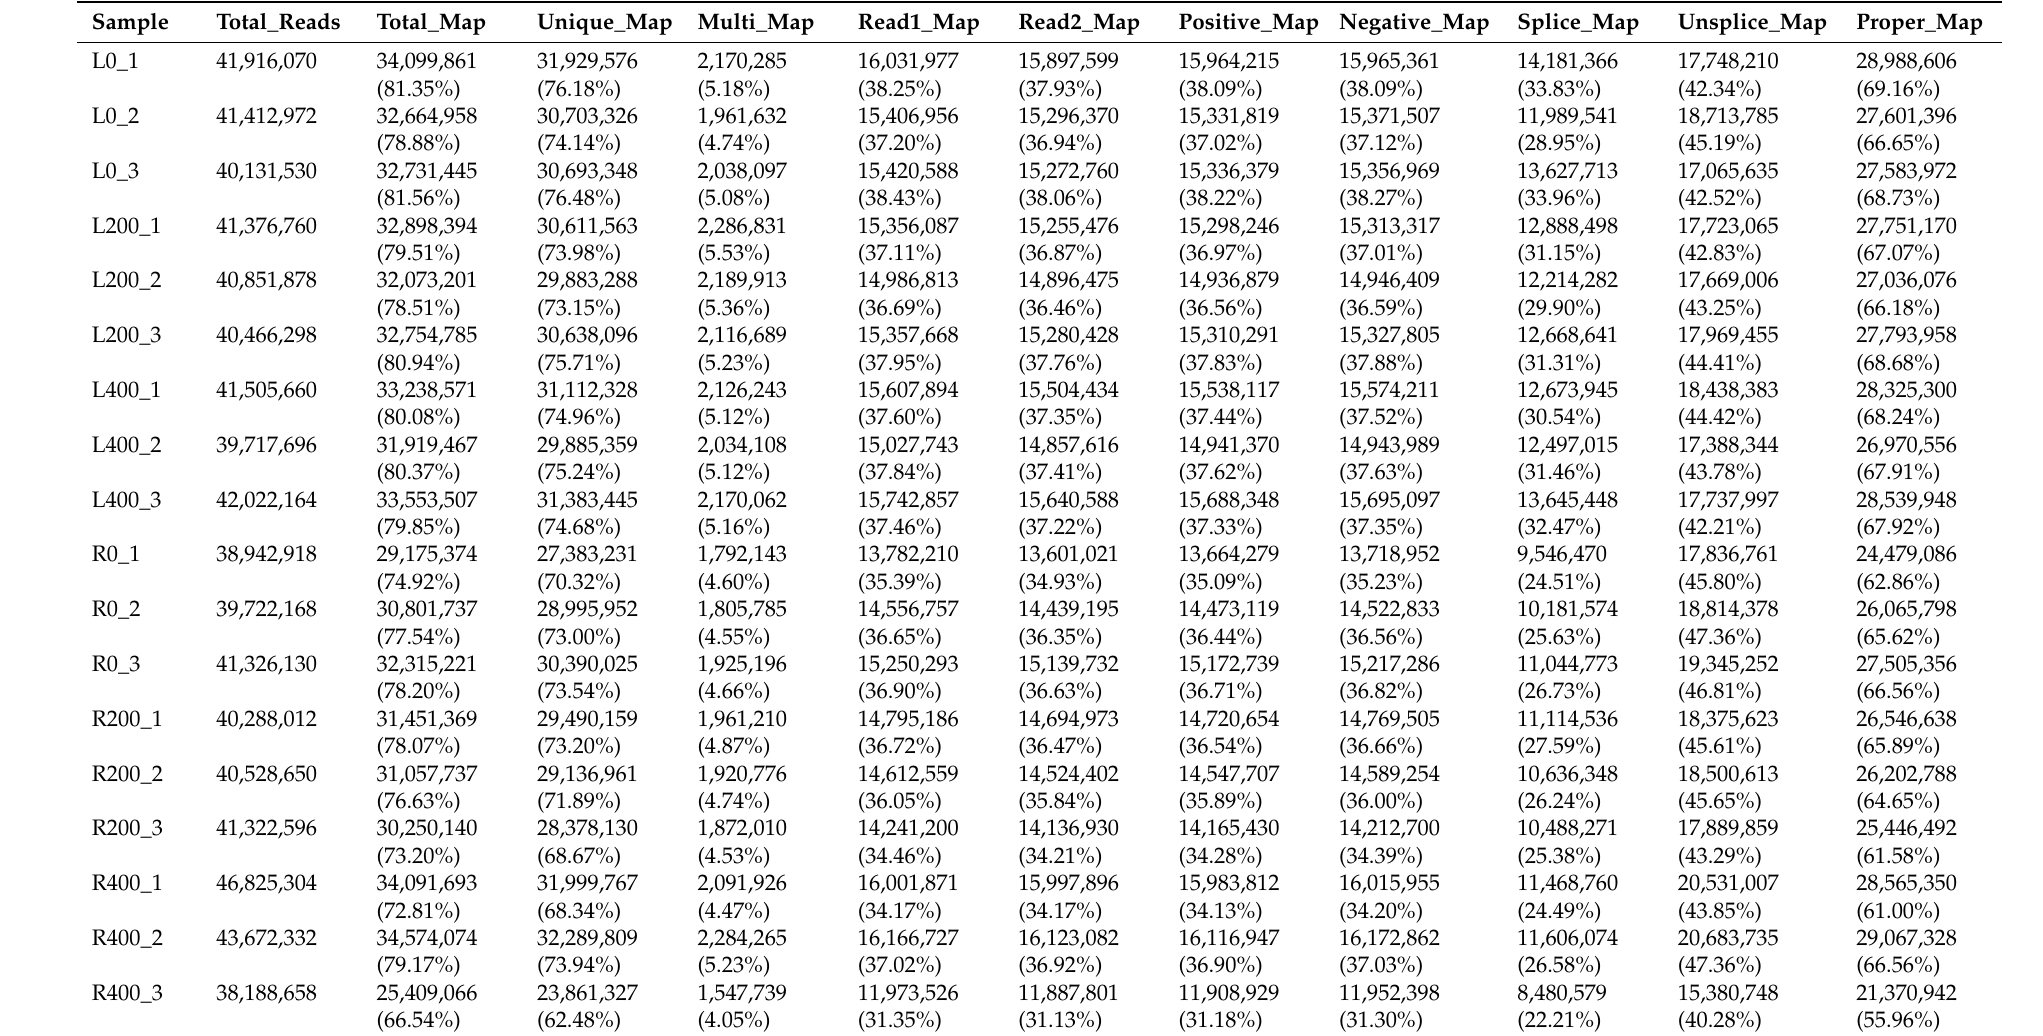
Table 2. Statistics of the comparison between samples and reference